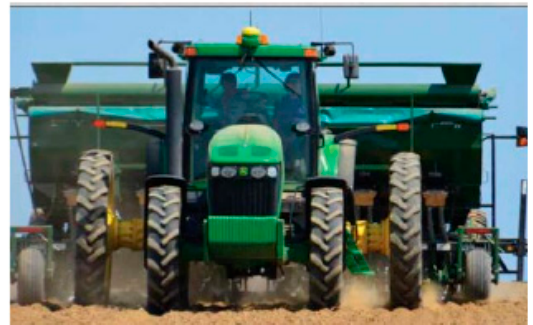
Figure 16. Harriston Pick Planter. Reprinted with permission from ref. [48] Copyright 2019 Harris- ton Industries.